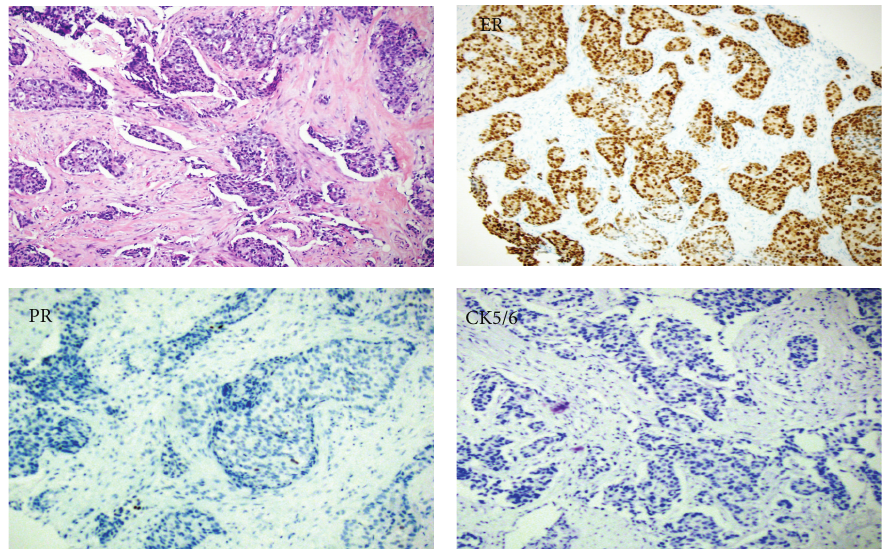
Figure 1: Breast core biopsy shows infiltrative nests of epithelioid cells with small ovoid hyperchromatic nuclei and modest eosinophilic cytoplasm separated by fibrous stroma with a desmoplastic reaction on H&E. Immunohistochemical stains show nuclear staining for ER and negative staining for PR and